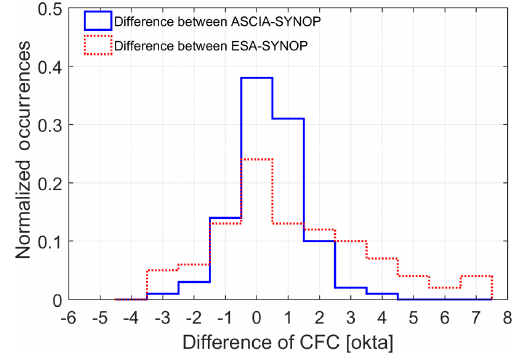
Figure 15. Histogram of CFC differences (blue is ASCIA minus SYNOP; red is ESA cloud product minus